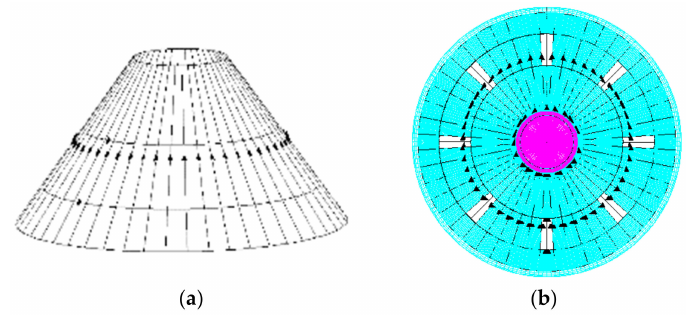
Figure 6. PAF model: ( a ) original state; ( b ) viscous damping state. Table 3. Fundamental frequencies in original state and in viscous damping state.